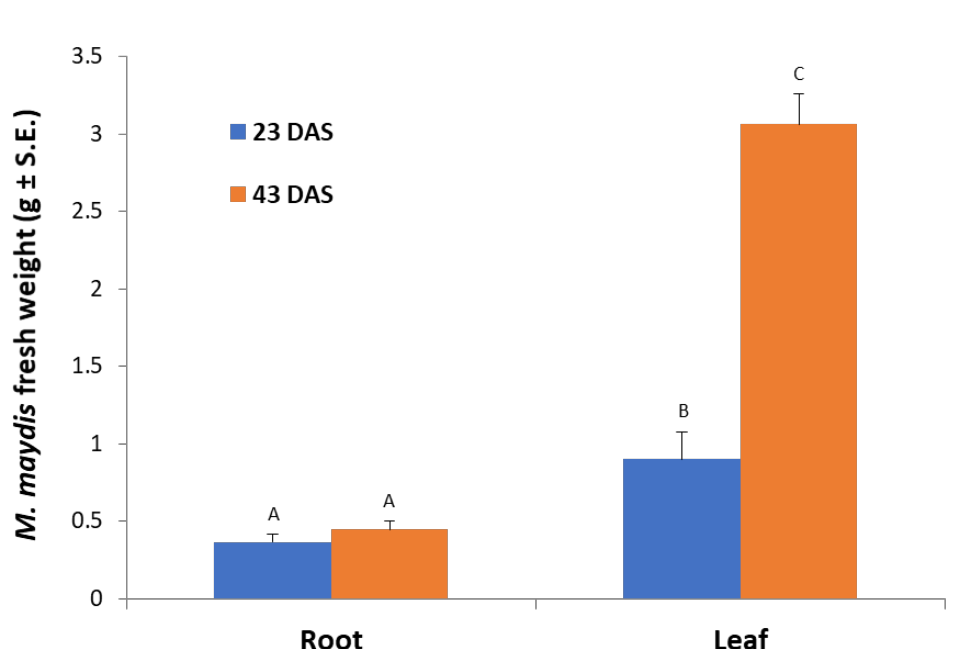
Figure 2. Effect of maize roots and leaves from plants at different ages on M. maydis growth: Corn plants from the Jubilee cv. were grown in a growth chamber for 23 or 43 days from sowing (DAS). The plants’ parts powder was added to submerged M. maydis cultures in MM without glucose. Each repeat consists of the entire roots or leaves of one plant. The values represent the average mycelia fresh weight of six repetitions obtained after seven days of incubation. Different letters (A, B, and C) mark a significant difference ( p < 0.05, ANOVA).